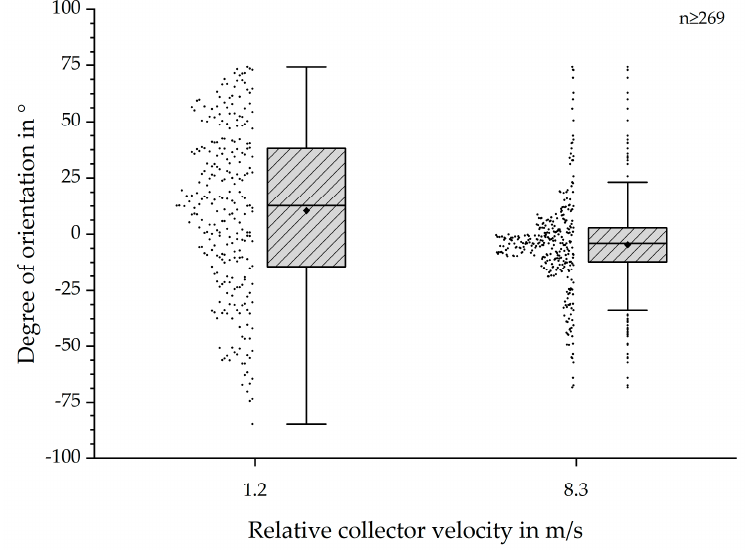
Figure 4. Boxplots of degree of fibre orientation in ° for 1.2 and 8.3 m/s relative collector velocity. The individually measured values are presented on the left side of each boxplot. The depicted boxplots show the results for the lowest relative collector velocity (1.2 m/s), which is defined as “control” for the Dunnett post-hoc test, and the results for 8.3 m/s without outliers. Both data sets show a distribution within a similar range, but for 8.3 m/s the majority of values is located around 0°. A much wider distribution for 1.2 m/s can be observed. The comparison of both data sets shows a decreased IQR and dispersion with increased relative collector velocity. The depicted IQR indicates normally distributed values.